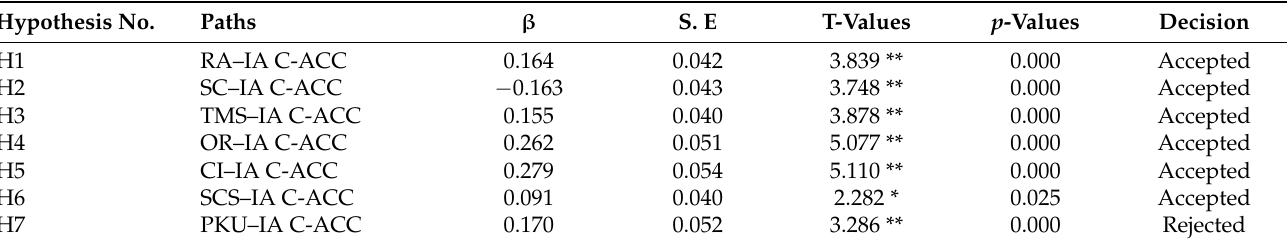
Table 5. Direct relationships model hypothesis testing result.